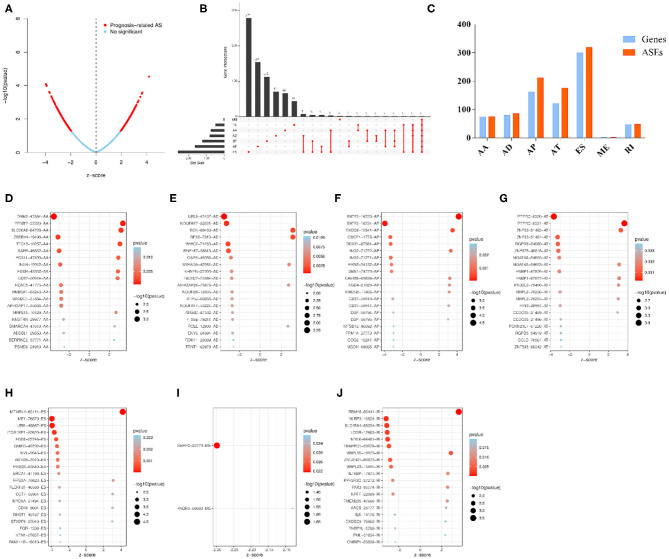
Overview of OS-ASEs affected by mRNA expression-related RBP mutations. (A) The volcano plot of all the ASEs. The red and blue dots represent OS-related and insignificant ASEs, respectively. (B) Upset plot of each type of OS-ASEs in SKCM. The black bar on the left side indicates the number of specific types of ASEs, while the red dots on the right side stand for the splicing intersections. (C) Distribution of seven types of ASEs and their corresponding genes. The x-axis represents each kind of ASEs (AA, AD, AP, AT, ES, RI), and the y-axis represents the number of ASEs (red) as well as the corresponding genes (blue). (D–J) Bubble plot of the most significant OS-ASEs in SKCM. (D) AA; (E) AD; (F) AP; (G) AT; (H) ES; (I) ME; (J) RI. The x-axis represents the z-score of each type of ASEs, while the y-axis stands for the OS-ASEs.